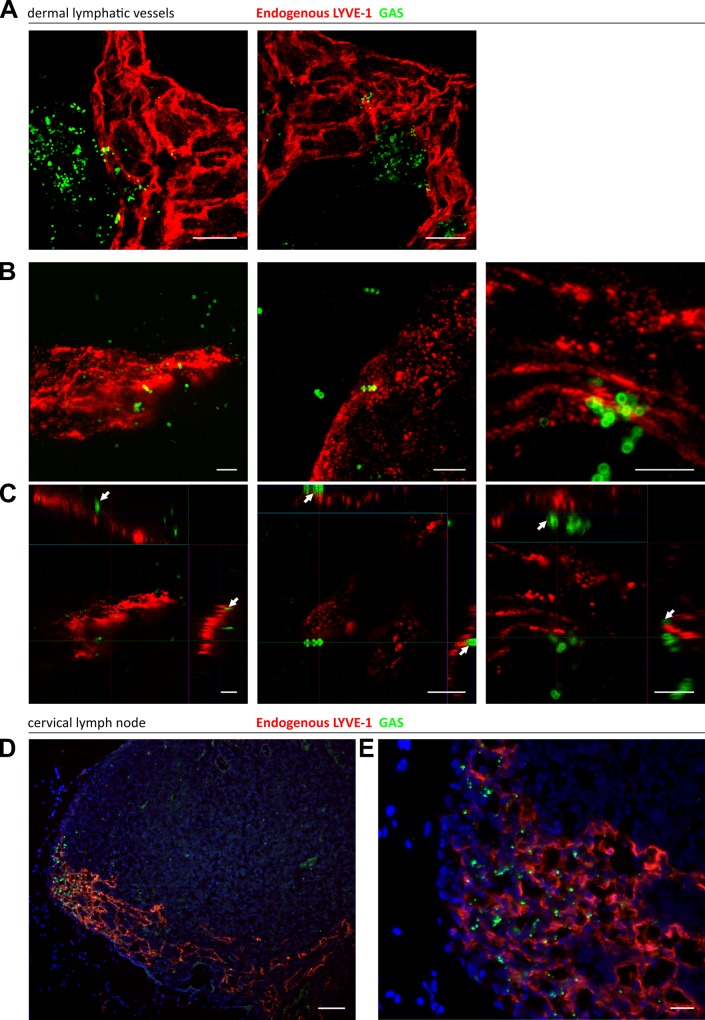
Trafficking of GAS visualized in dermal lymphatic vessels and draining cervical lymph nodes of the mouse ear pinna.A-C: Confocal microscopic images of murine ear skin 6–24 hours after local intradermal inoculation. (A) Low magnification images of lymphatic vessels in skin and surrounding infected tissue 24 hours post infection (scale bar 20 μm). (B) 3D rendered images and (C) orthogonal views of the same z-stacks at 6 hours post infection. Arrows indicate individual streptococci interacting with LYVE-1 dense regions of lymphatic vessel endothelium (scale bar 5 μm). D-E: Epifluorescence microscopic images of frozen sections of draining cervical nodes 6 hours post infection at low power (100X magnification)(D) and high power (400X)(E) (Scale bar 50 μm and 20 μm respectively). Red = LYVE-1, green = GAS, blue = nuclei. Arrows indicate encapsulated GAS adhering to clusters of LYVE-1.